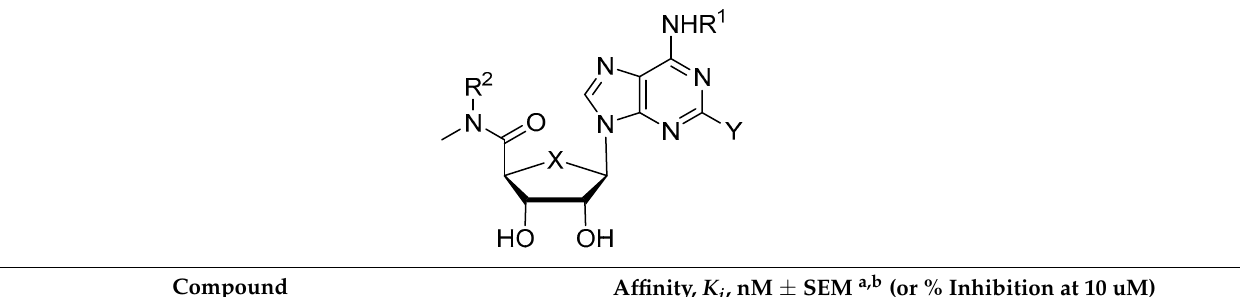
lower binding affinity than the 4 (cid:48) -seleno-5 (cid:48) - N -methyluronamide derivatives 7 and 8 . It is interesting to note that 2-Cl- N 6 -3-iodobenzyl analogue 9l exhibited much weaker binding affinity than the corresponding 2-H analogue 9f . This tendency was also found in the 5 (cid:48) - N -methyluronamide 4 (cid:48) -seleno derivatives 7 and 8 . Table 1. Binding affinities of known A 3 AR ligands and 5 (cid:48) - N,N -dimethyluronamide-4 (cid:48) -selenonucleoside derivatives ( 9a–l ) at human A 1 , A 2A , A 2B , and A 3 ARs.